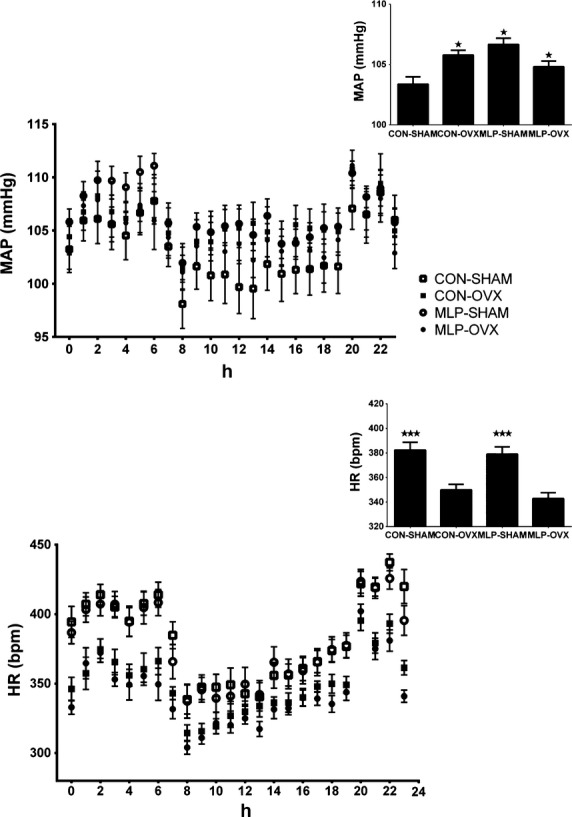
Mean arterial blood pressure (MAP) and heart rate (HR) in control (CON) and low-protein (MLP) intact (SHAM) and ovariectomized (OVX) offspring at 12 months of age. Data were collected continuously over a 5 day period by radiotelemetry and means calculated to give a 24 h profile. A two-way ANOVA looking at the diet and ovariectomy effects showed that MAP was the lowest in the CON-SHAM during light cycle, (*P < 0.05 compared to CON-SHAM) and there was a tendency for it to be lower over full 24 h period, P = 0.06. HR was significantly increased in OVX group (***P < 0.001 compared to OVX of same dietary background).